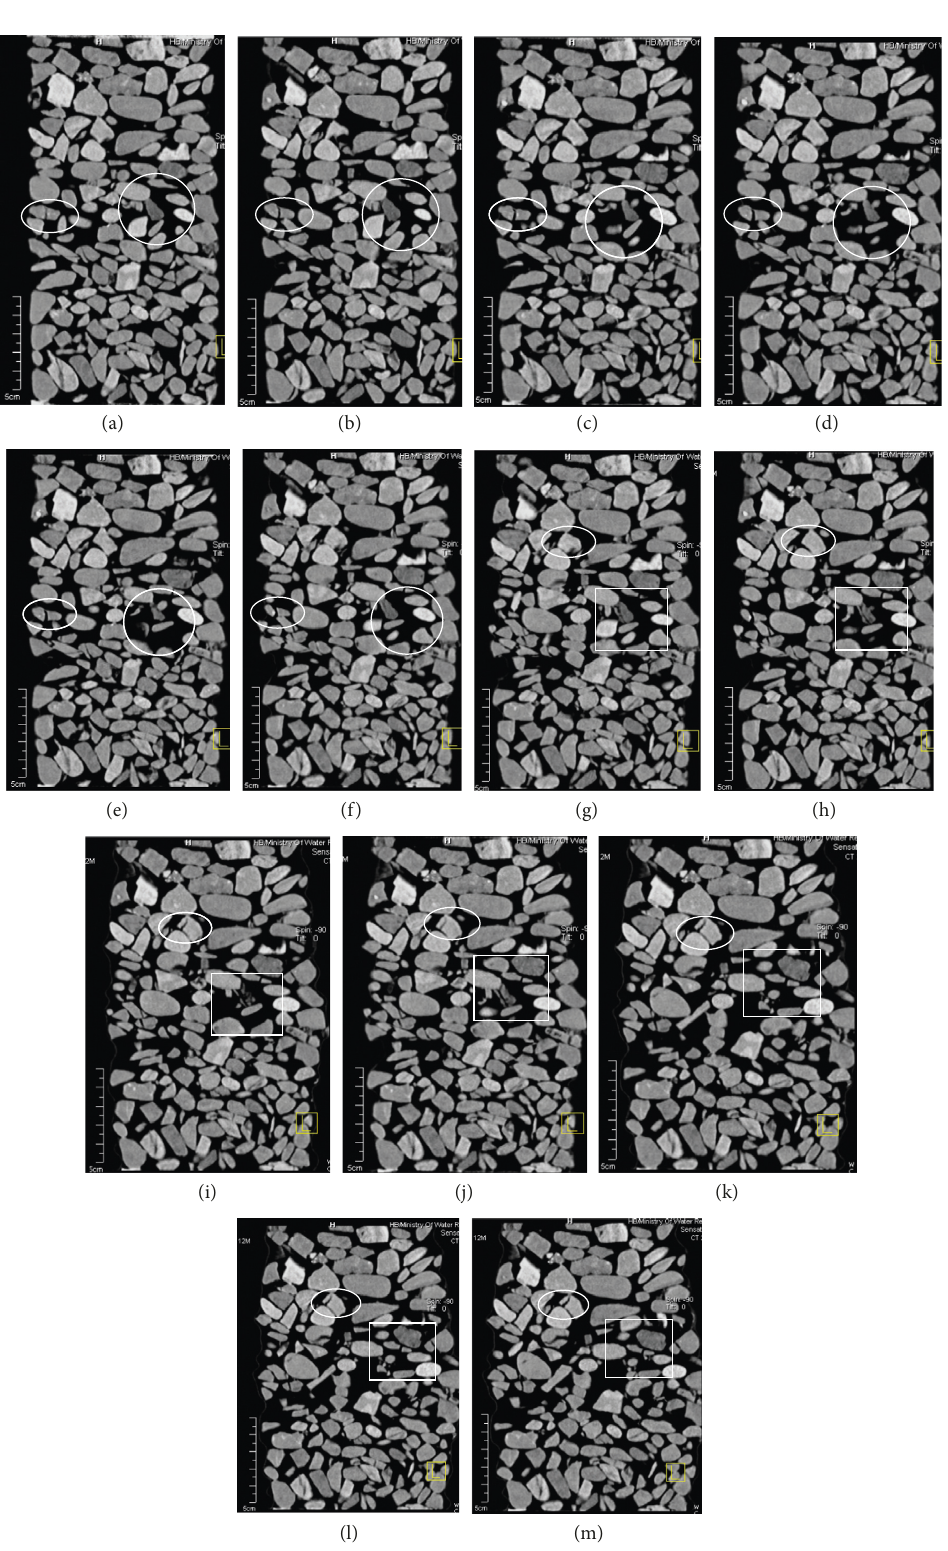
Figure 5: Vertical sectional images of the test sample ( σ � 5.2%. (g) ε (f) ε a